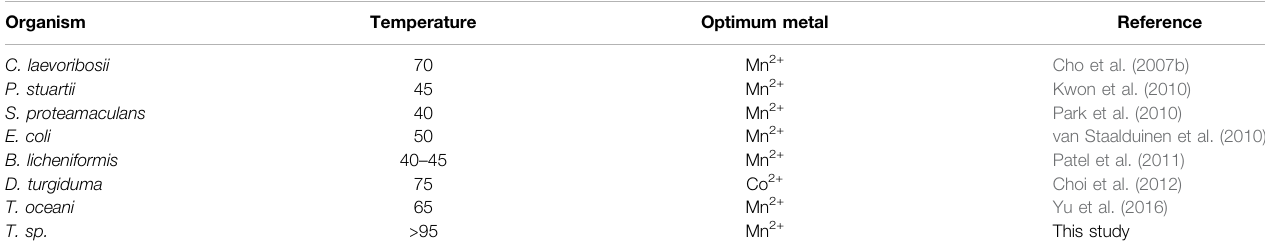
TABLE 1 | Comparison of the optimal temperature and of the metal dependencies of several characterised lyxose isomerases.